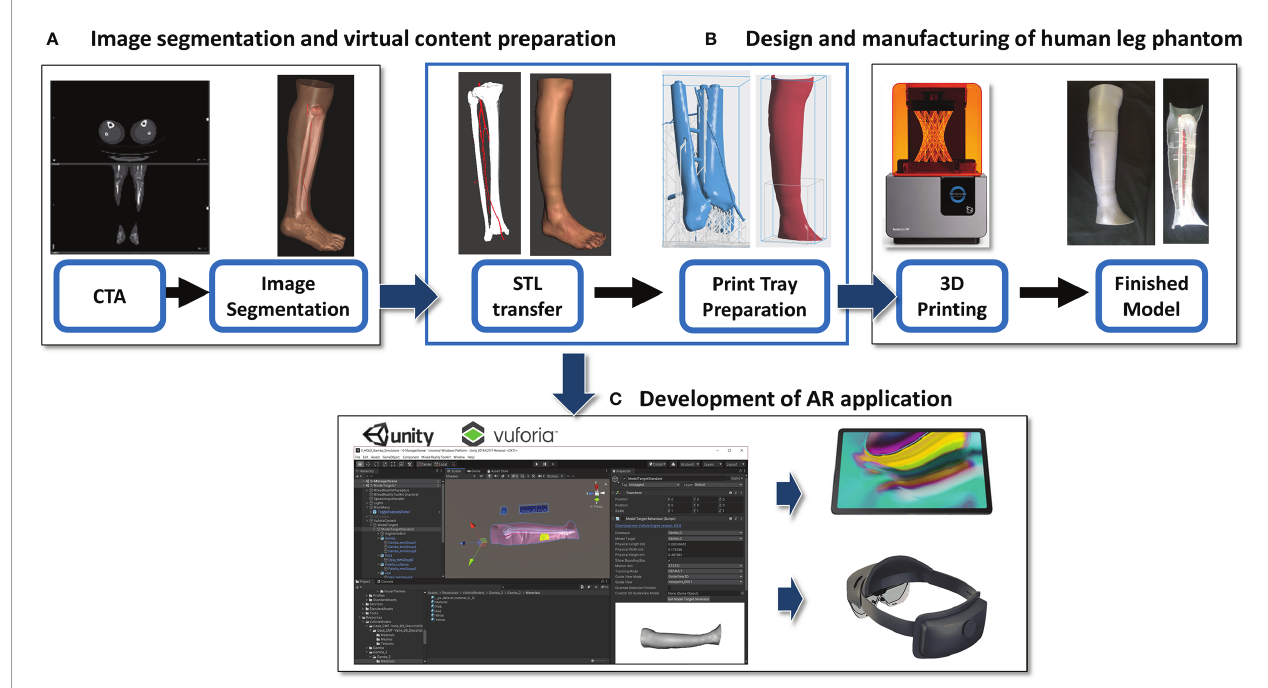
FIGURE 1 | Description of the development work fl ow. (A) Image segmentation and virtual content preparation; (B) Design and manufacturing of the human leg phantom; (C) Development of the AR